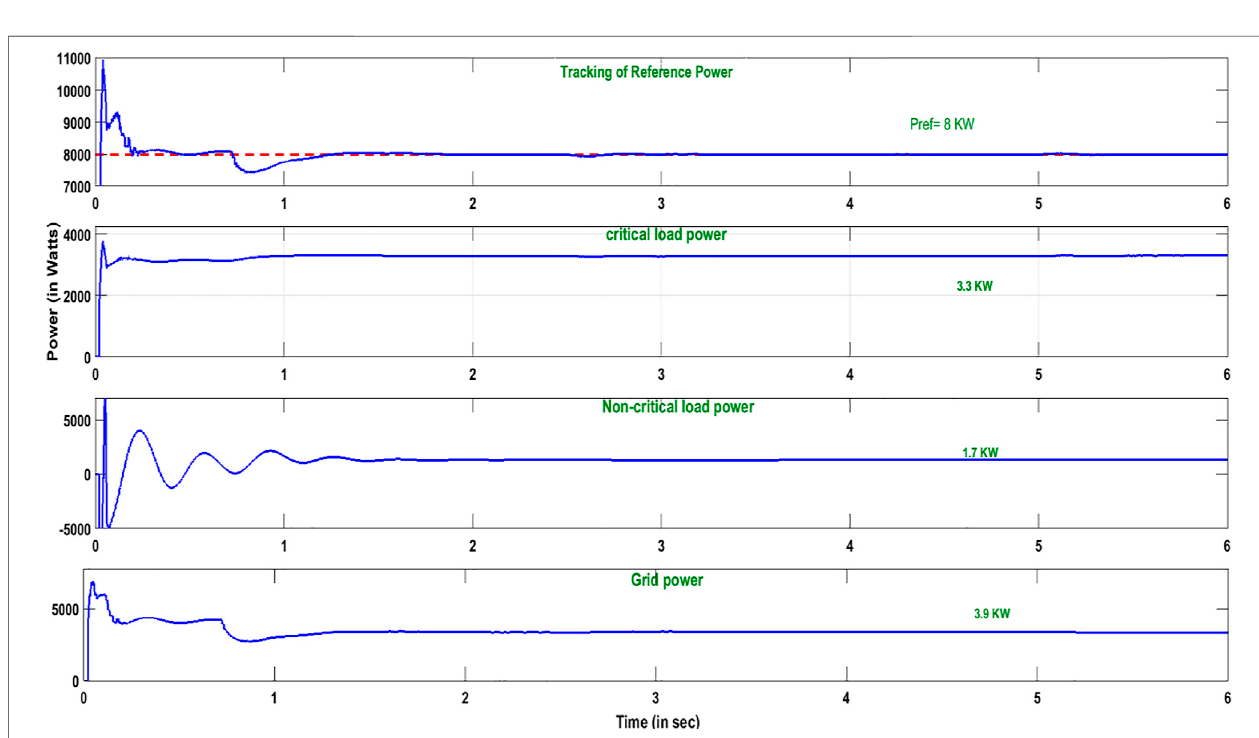
FIGURE 4 | Power variations for a constant reference power to